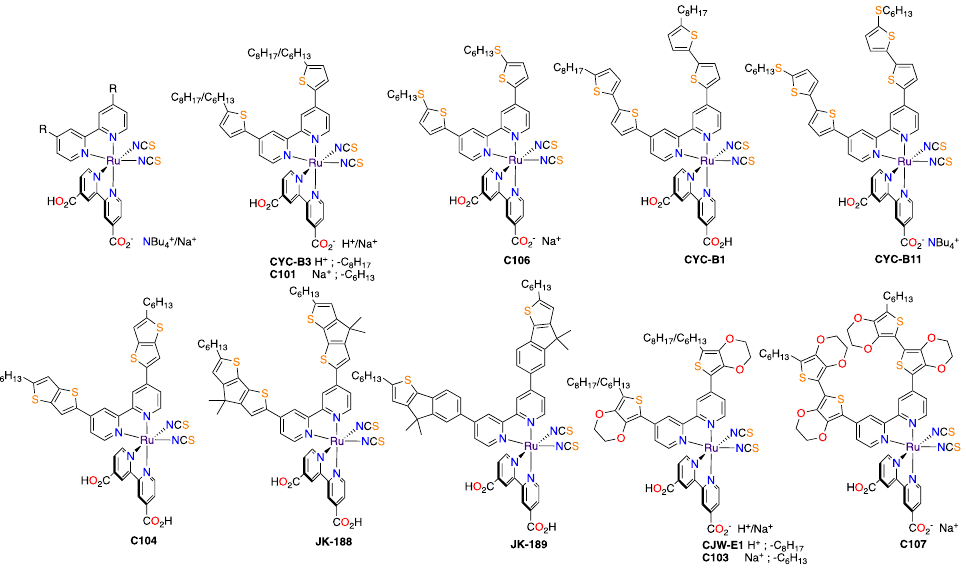
Figure 6. Some of the tris -heteroleptic isothiocyanate ligated Ru(II) complexes with thiophene-based substituents on the ancillary ligand.